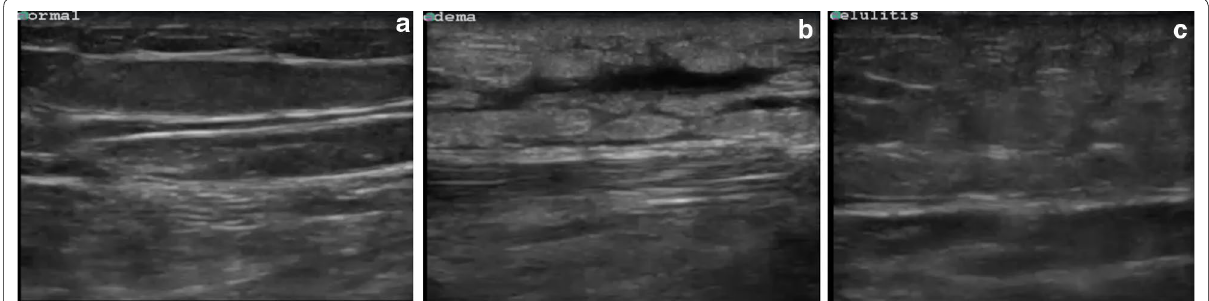
Fig. 5 Point-of-care ultrasound scan of a different patient showing normal soft tissue ( a ), peripheral edema ( b ) and cellulitis ( c ) using a 15–6 MHz linear